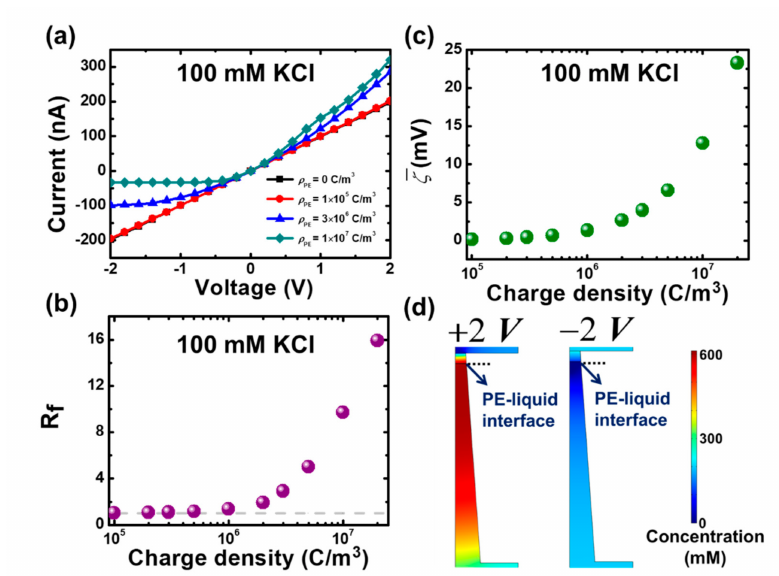
Figure 3. ( a ) Simulated current–voltage (I–V) curves of the considered mesopore system with various space charge densities ( ρ PE ) at C salt = 100 mM. (b) Rectification ratio ( R f ) and ( c ) the averaged zeta potential ( ζ ) as a function of ρ PE at C salt = 100 mM. The dashed curve in (b) is the rectification ratio ( R f = 1) for the bare mesopore system in the absence of a PE layer. ( d ) Spatial variations of the total ion concentration in the considered mesopore system with ρ PE = 1 × 10 7 C/m 3 for the two applied voltages with opposite signs at C salt = 100